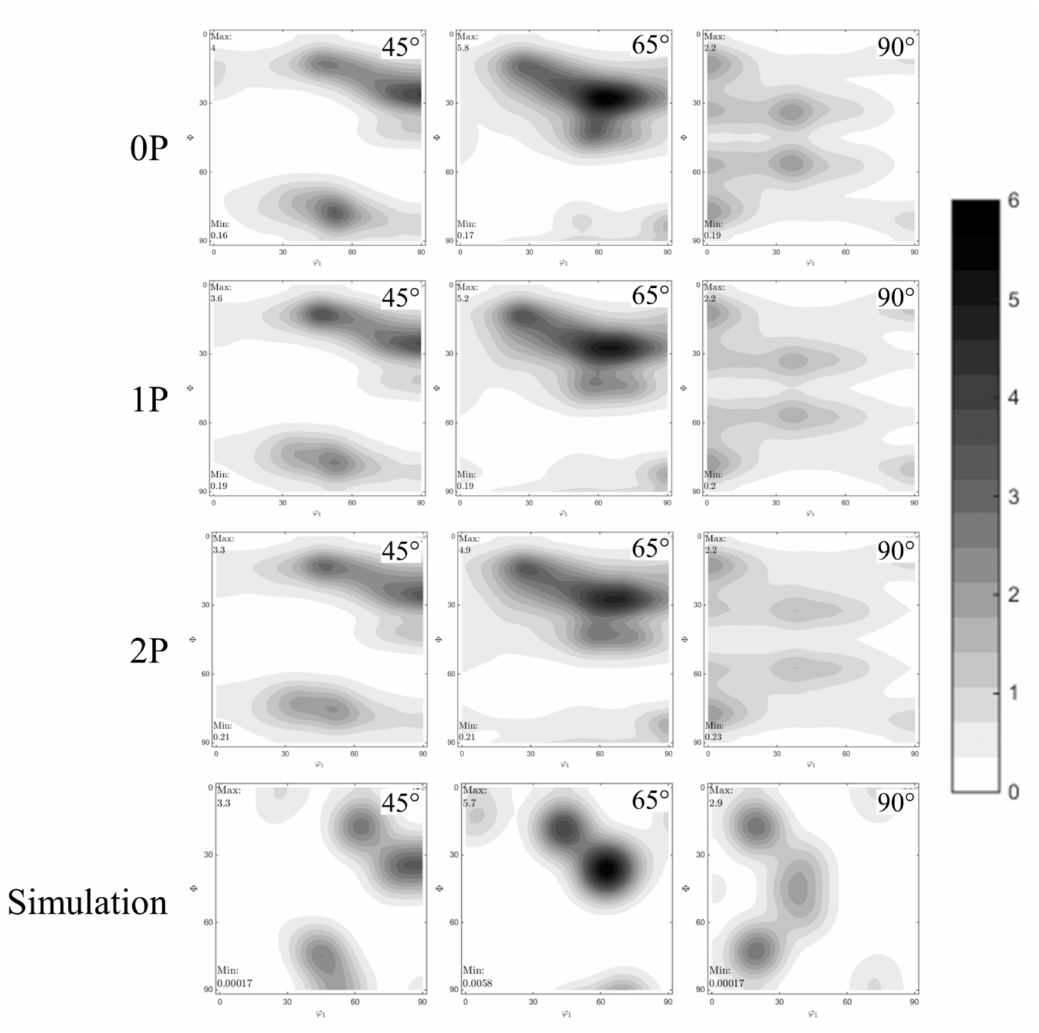
Figure 8. Evolution of the ODF’s on samples at 0P, 1P, 2P deformation passes, and the key components of the identified texture.